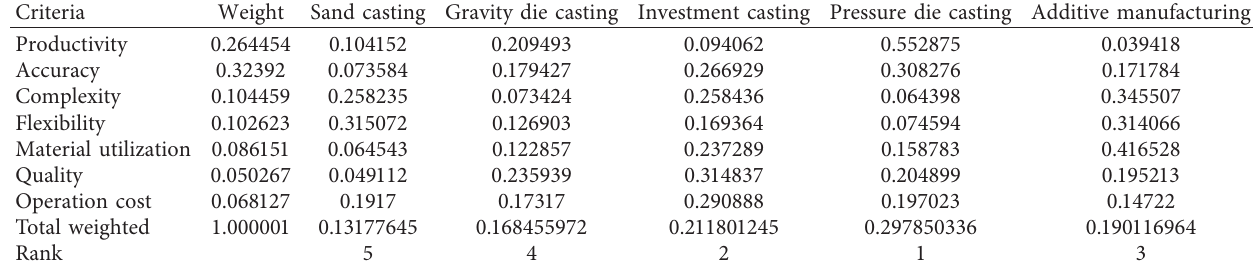
Table 4: AHP results for the case